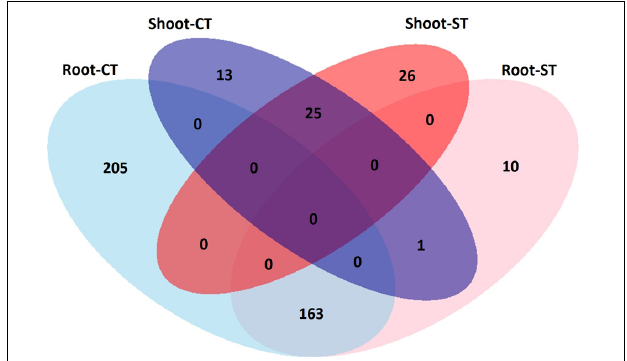
FIGURE 5 | Venn diagram displays the number of OTUs that significantly differentiate root and shoot compartments in the indicated tillage regime; CT and ST (Wald test, P < 0.05, FDR